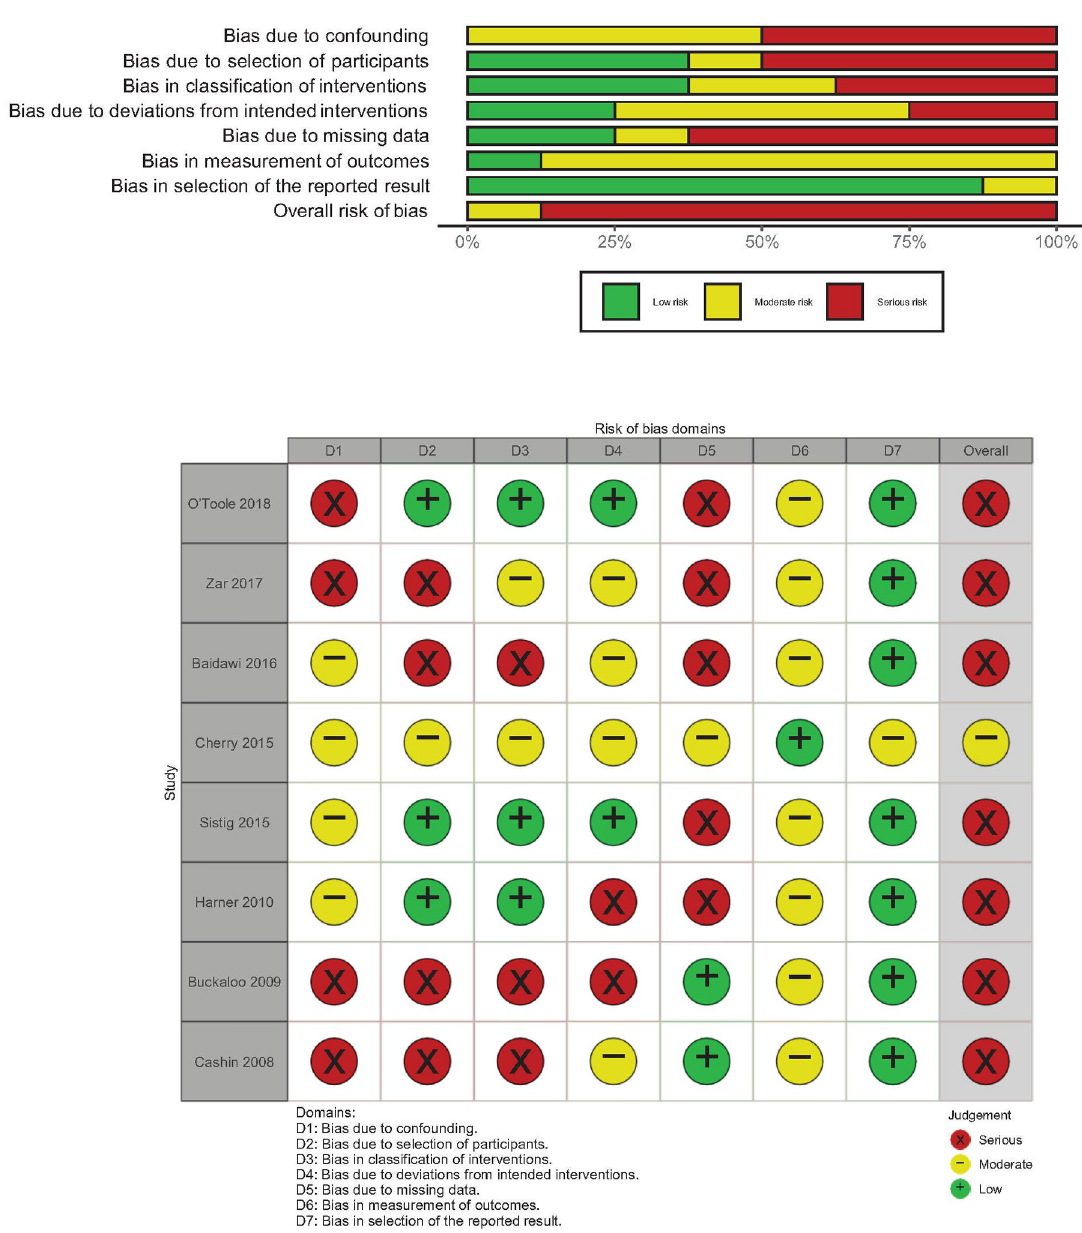
Fig 3. Risk of bias assessment for the included non-randomized studies of